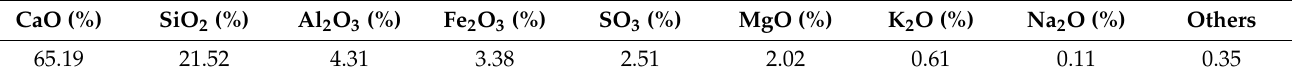
Figure 2. Cement. Figure 2. Cement. Table 2. Chemical composition of ordinary Portland